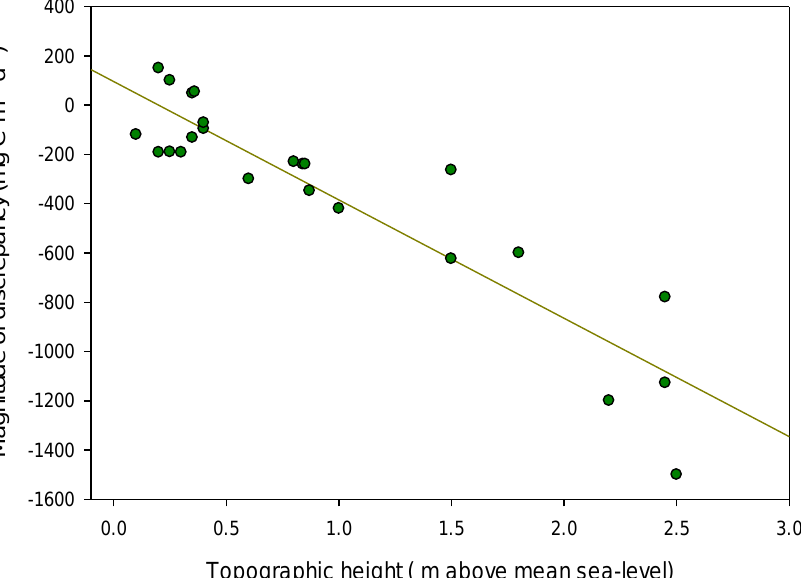
Figure 4. An inverse relationship of increasing discrepancies between surface and subsurface mineralization rates with increasing topographic height in various mangrove forests of Timor-Leste, Thailand, Malaysia, Indonesia, and Australia. Data obtained from references [54–63].